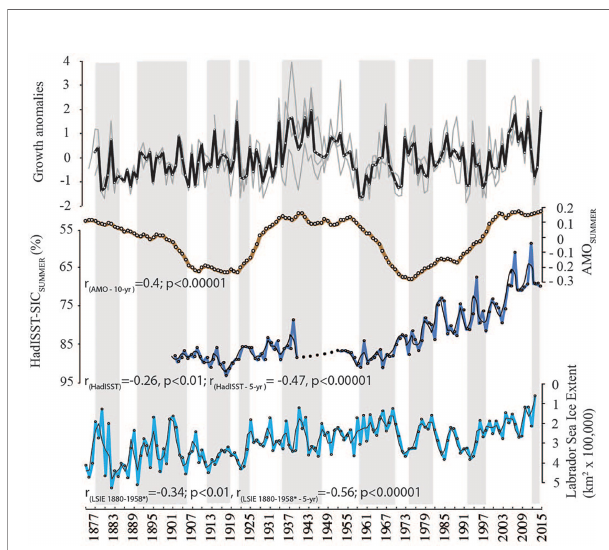
FIGURE 9 | Relationship between crossdated master chronology (thick black line) and long-term sea ice-related records. Algal growth increments standardized as anomalies. Individual algal sample averages (grey); AMO: (May-October; brown); HadISST (data gathered from KNMI Climate Explorer 1° spatial resolution; 79-80°N to 91-92° W); dark blue, missing years shown in dotted black line); Labrador Sea Ice Extent (i.e., LSIE; Jan-Apr average; *1- year lag (Hill and Jones, 1990). Light black line in LSIE and HadISST records are 2-year running